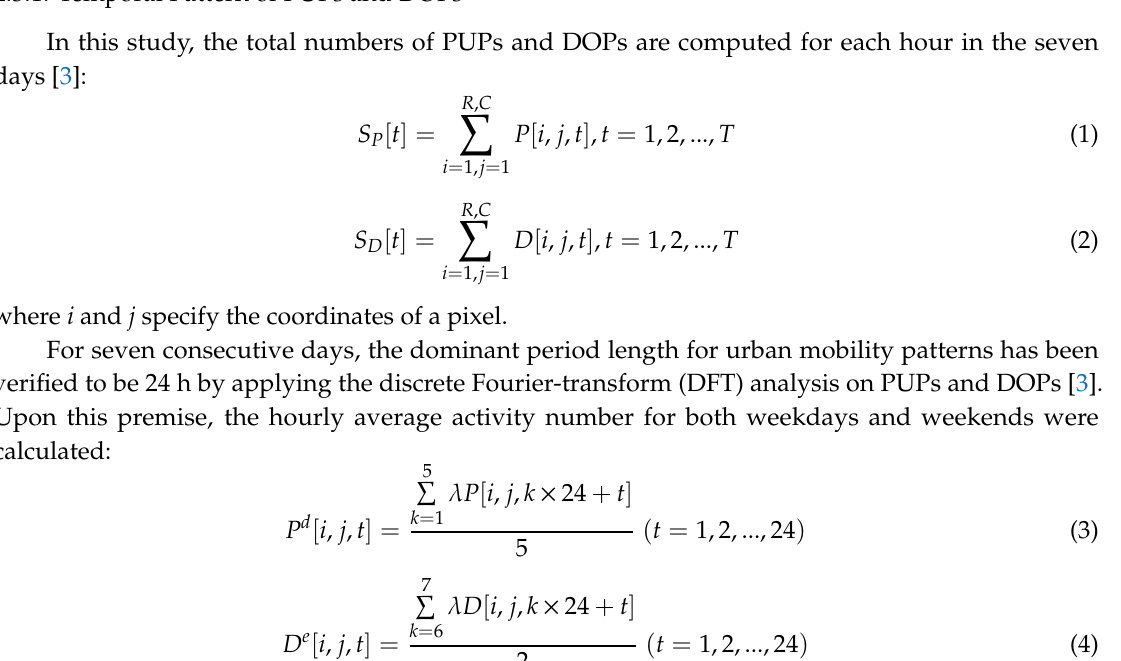
Figure 2. Spatial distributions of the density of pick-up points (PUPs) and drop-off points (DOPs).